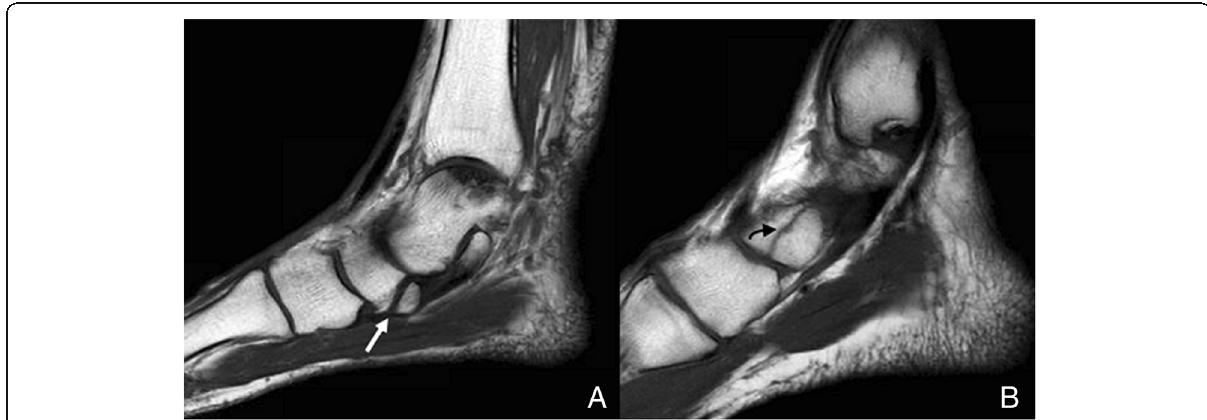
Fig. 5 Differential diagnosis type II accessory navicular and navicular fracture. a Sagittal FSE T1 showing the incidental finding of a type II accessory navicular (white arrow). Note how the synchondrosis represents a regular line. b A 51-year-old man with history of sprain several months ago and persisting pain in the medial aspect of the midfoot. Sagittal FSE T1 demonstrates the sequel of a transverse slightly irregular hypointense line of fracture through the navicular, with no displacement of fragments (curved black